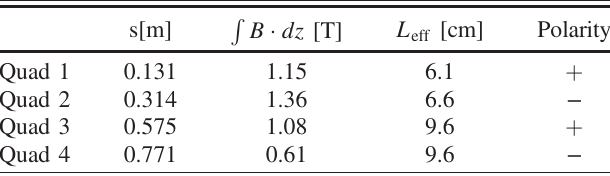
TABLE I. Parameters for quadrupoles in first 1.3 meters of BTF MEBT.